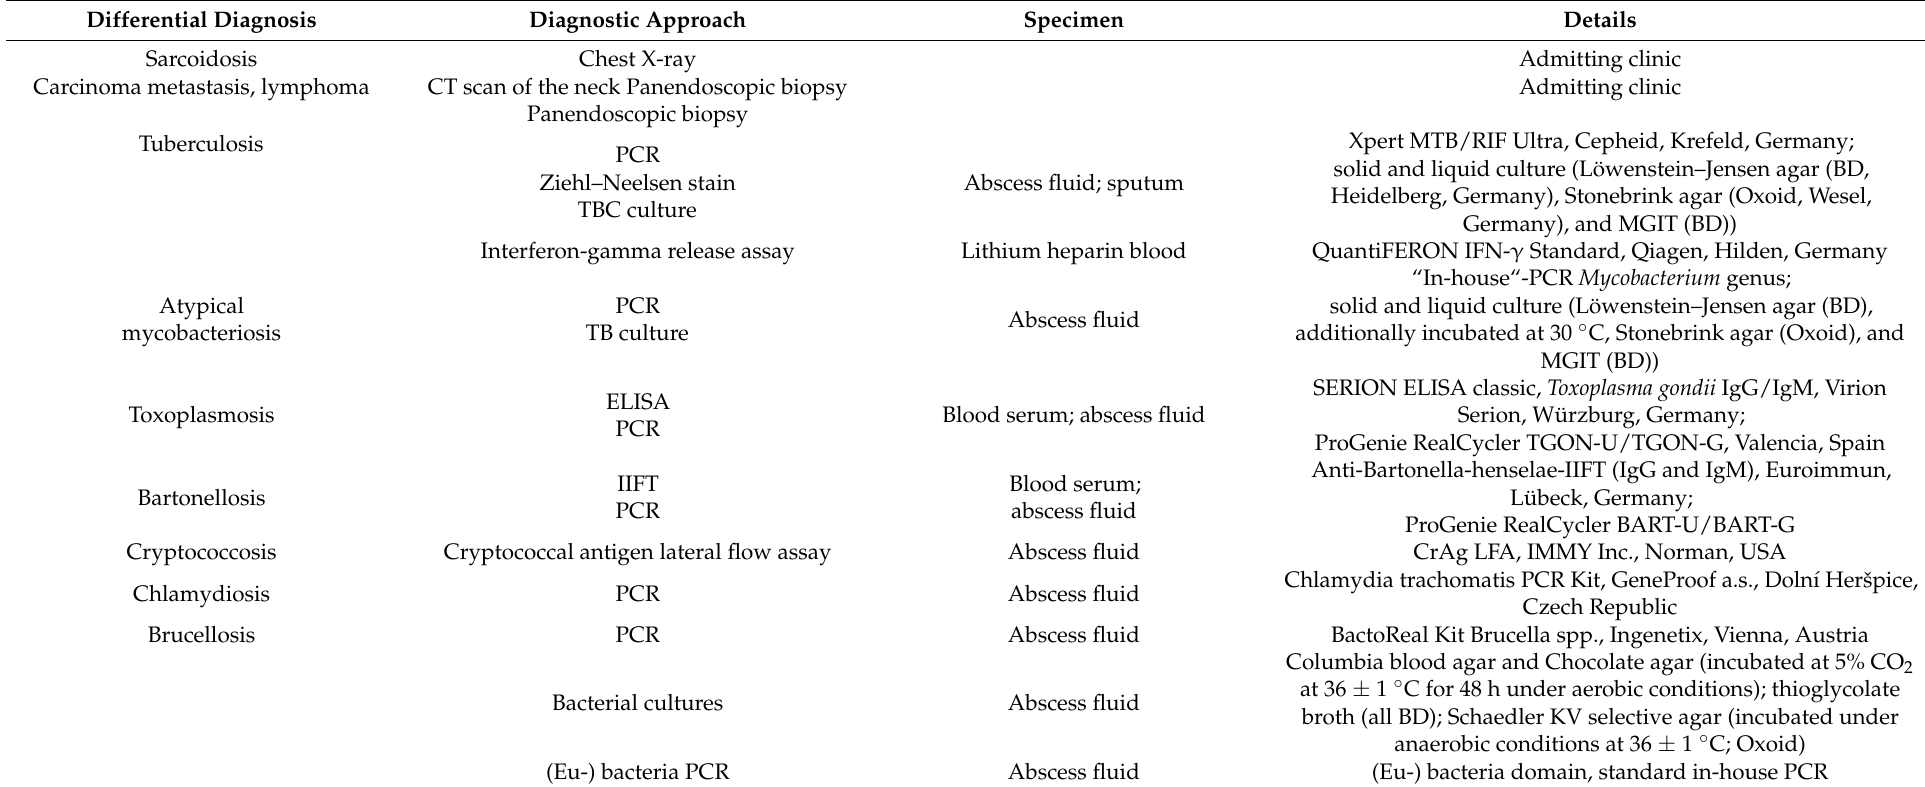
Table 1. Considered differential diagnoses, and their diagnostic